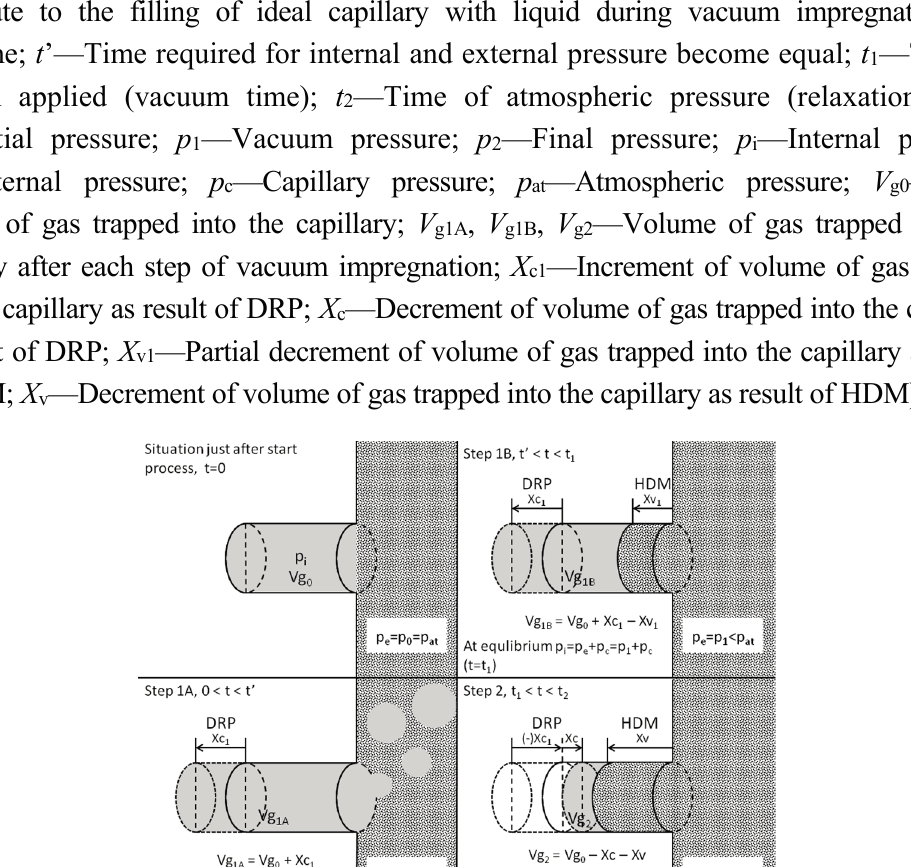
Figure 1. Hydrodynamic mechanism (HDM) and deformation-relaxation phenomena (DRP) contribute to the filling of ideal capillary with liquid during vacuum impregnation